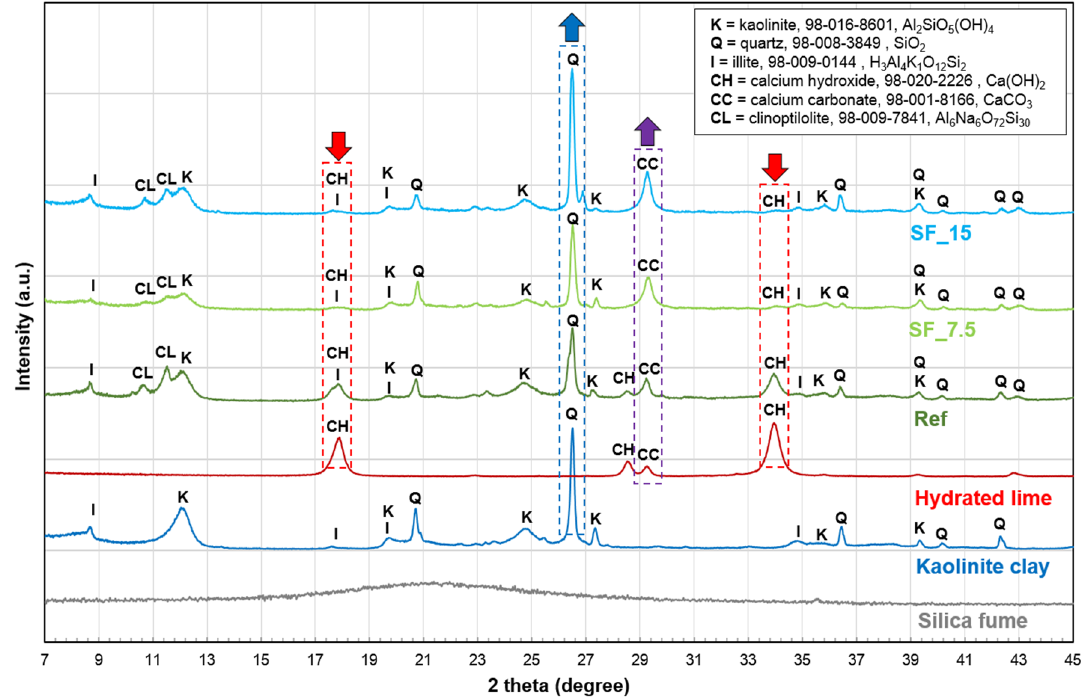
Figure 4. X ‐ ray diffraction spectra with qualitative analysis of kaolinite clay based mortars.